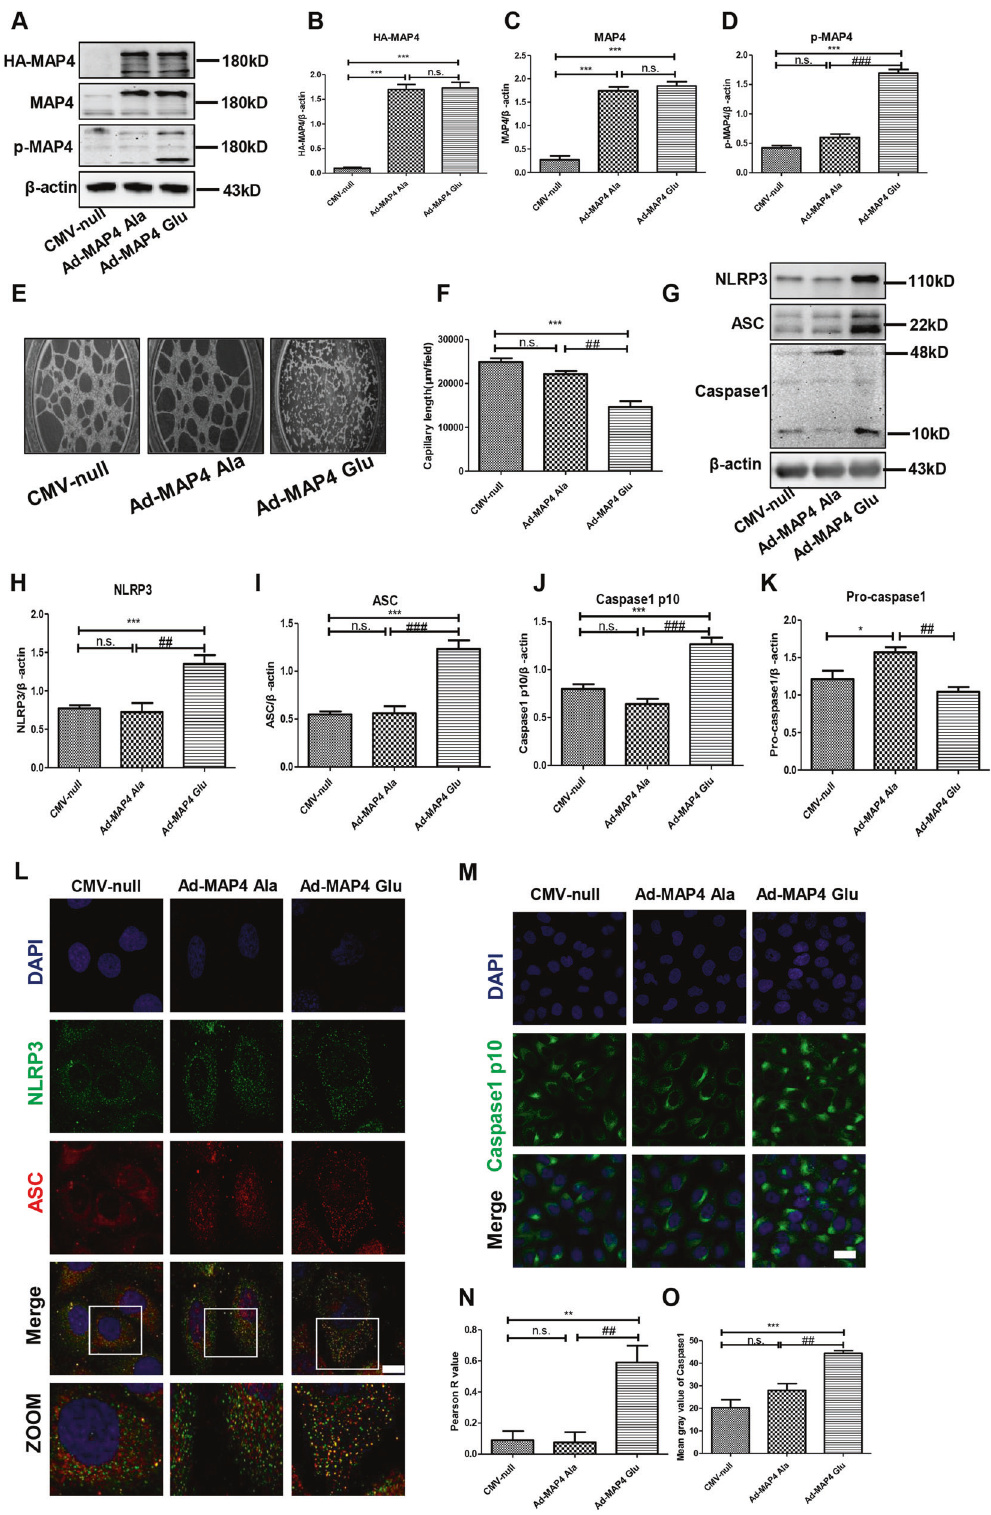
1 (p10) generation. As shown in Fig. 4L, when compared with CMV-null and Ad-MAP4 (Ala) group, the NLRP3/ASC colocalization was markedly increased in Ad-MAP4 (Glu) group. In line with this, a higher Pearson R value was observed in Ad-MAP4 (Glu) group (Fig. 4N, p < 0.01). Meanwhile, the fl uorescence intensities